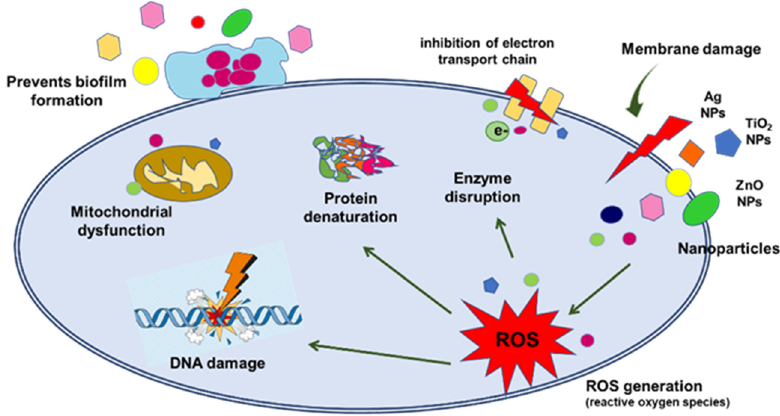
Figure 2. Antimicrobial mechanisms of various nanoparticles (adapted from ref. [25]).